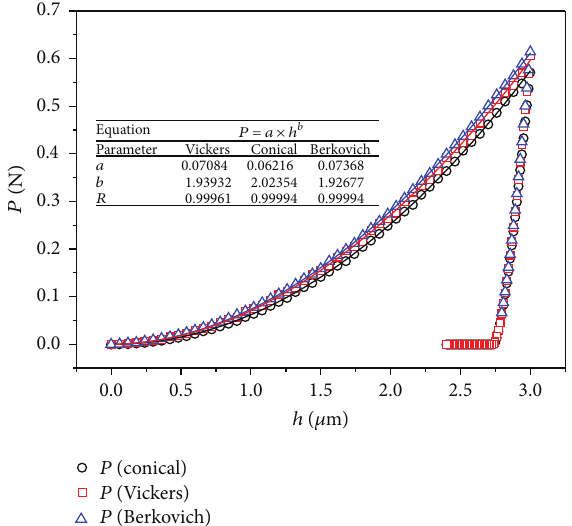
Figure 3: Force-displacement curves for different kinds of inden- ters. The solid lines are the power law fitting of the loading parts. 𝐸 = 100 GPa, 𝑌 = 800 MPa.